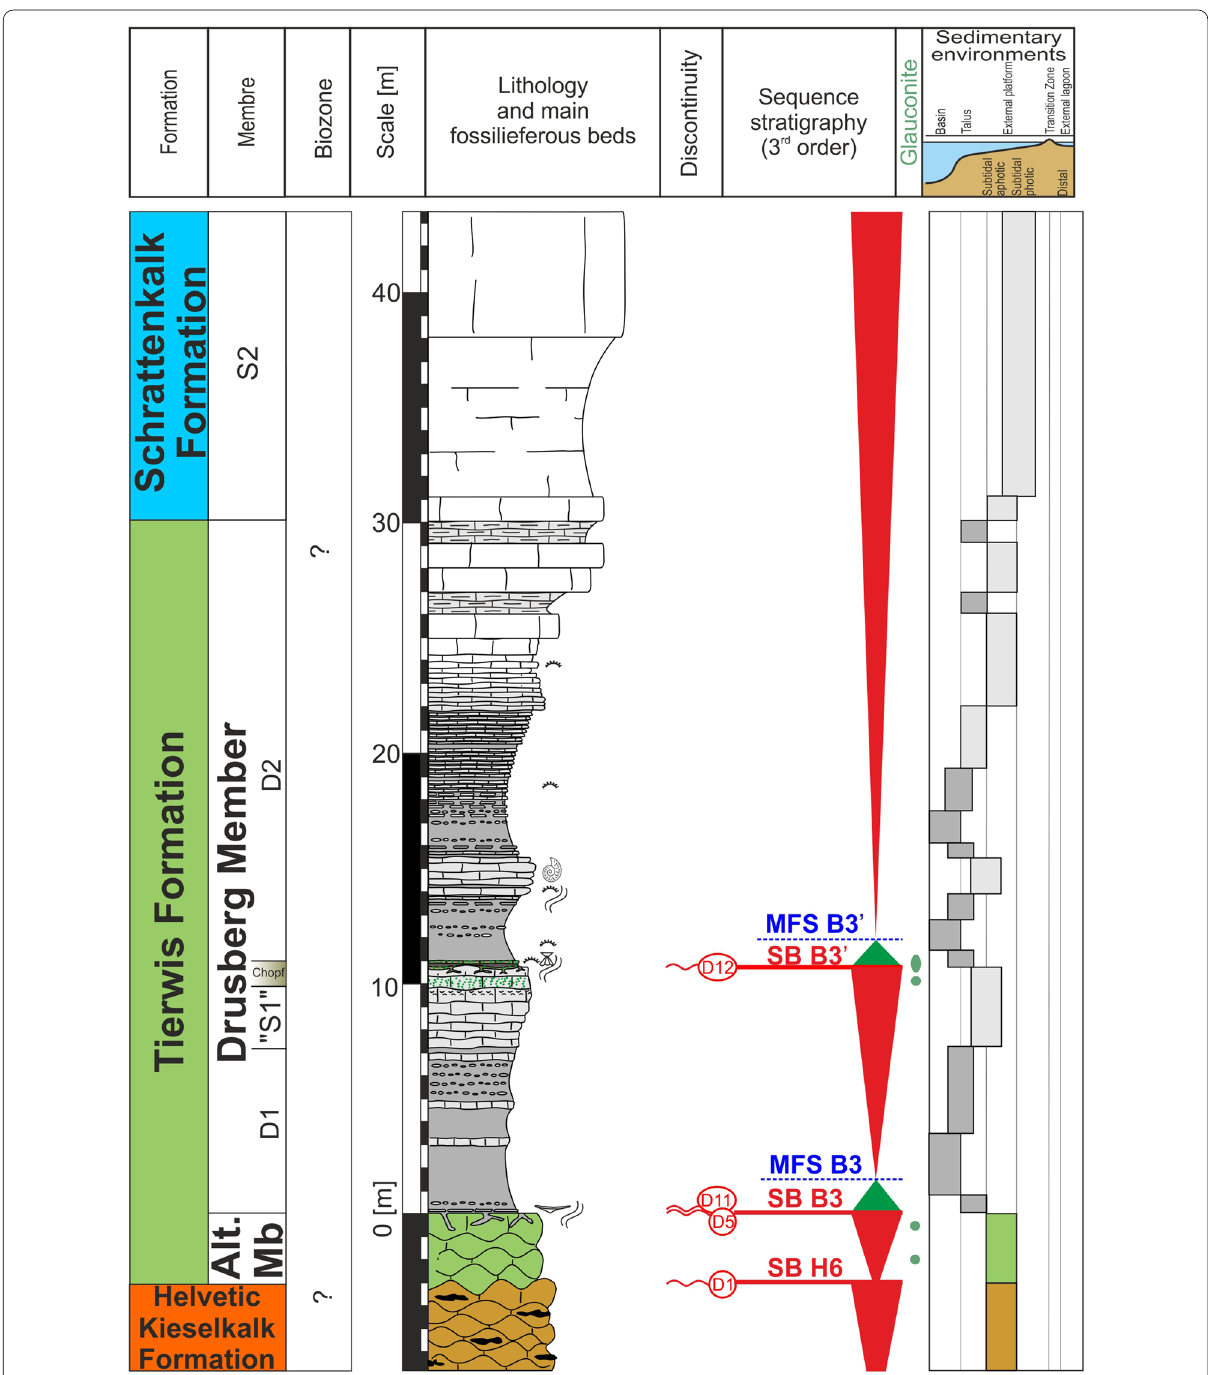
Fig. 14 Zeheloch section. Lithological log with main fossil-bearing levels, discontinuities, sequence stratigraphic interpretation and